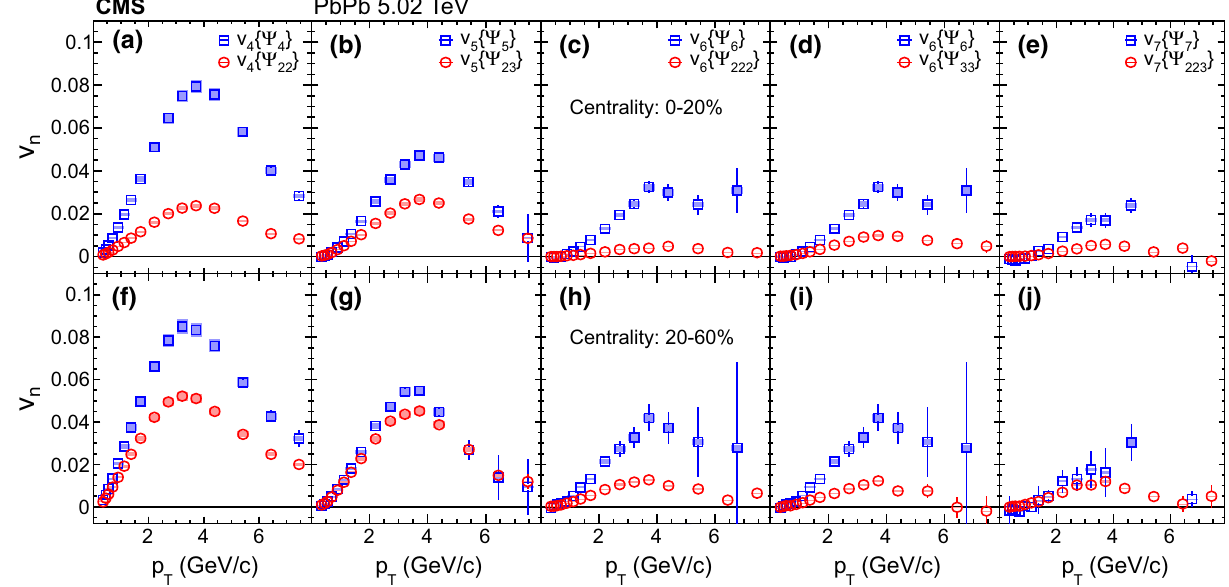
√ = 5 . 02TeV as a function p s NN 20–60% (lower row) centrality ranges. Statistical (bars) and systematic (shaded boxes) uncertainties are